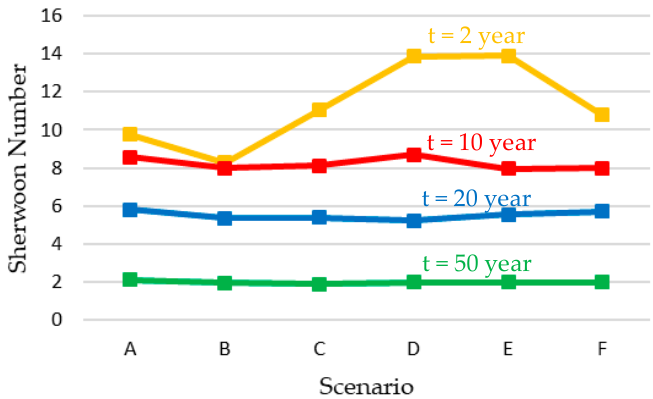
Figure 13. The local Sherwood number beneath the source zone for all the scenarios at 2, 10, 20 and 50 years.